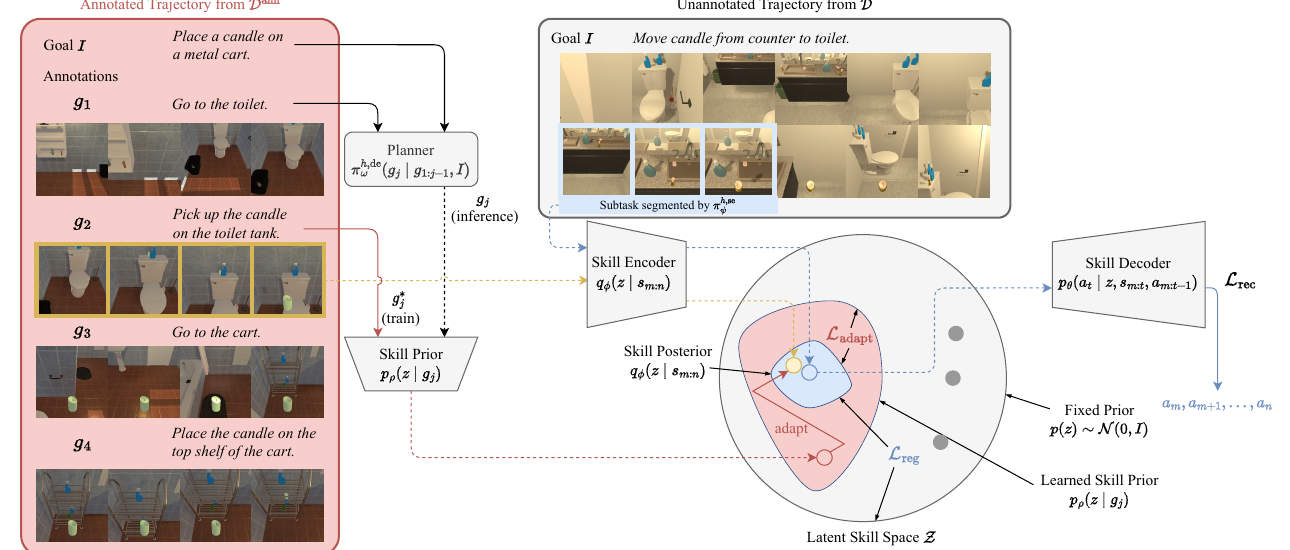
Figure 2. Architecture of the SLHSP. The skill encoder and decoder are self-supervised on D , while the skill prior, planner and separator are supervised using annotated trajectories D ann